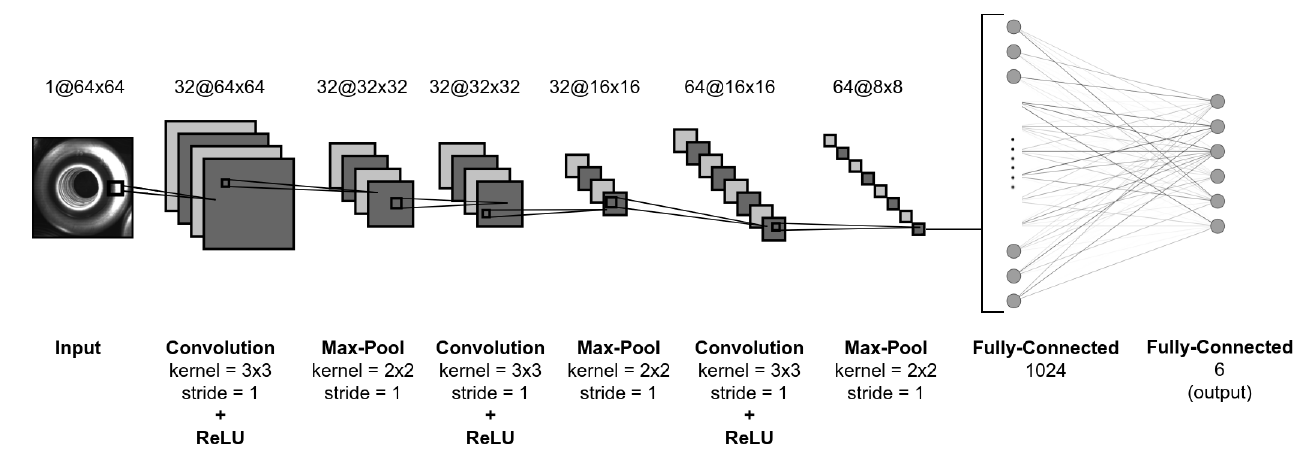
Figure 12. CNN architecture for object pose